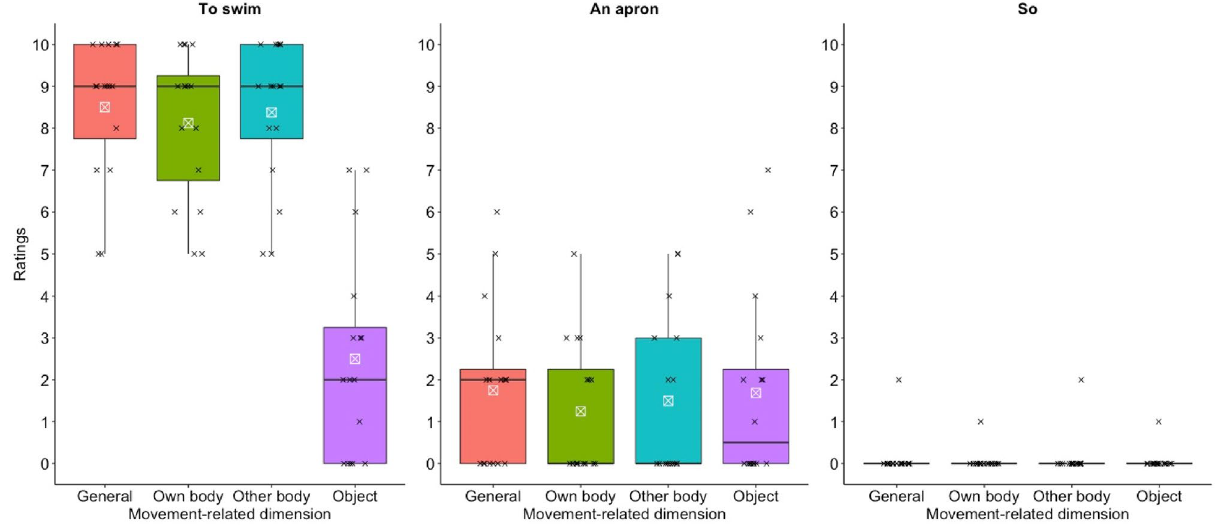
Figure 2. Individual ratings of the middle words from the lists (Table 5) for ‘highest’, ‘median’, and ‘lowest’ average ratings of own-body movement-relatedness. Cross signs indicate the per-rater